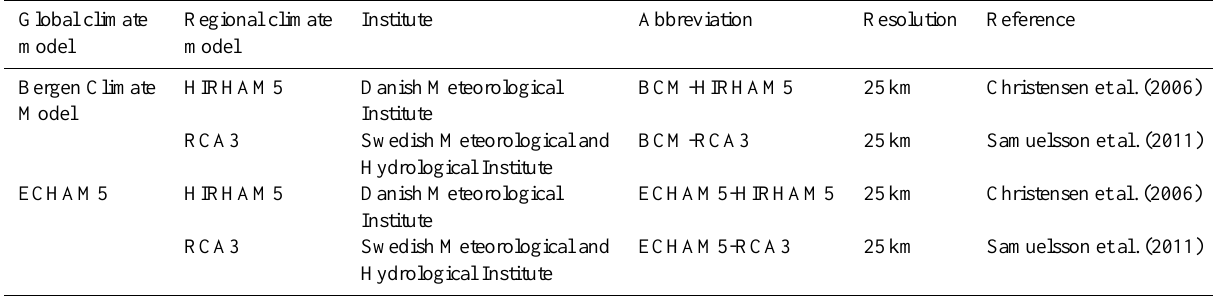
Table 1. The driving global model for each simulation is given in the first column. The regional climate model used and the institute who performed the downscaling are given in second and third column, respectively. The fourth column shows the abbreviation that is used in this paper for each of the simulations, while the fifth column gives the horizontal resolution of the RCM. The final column provides a reference where full details of the RCMs can be